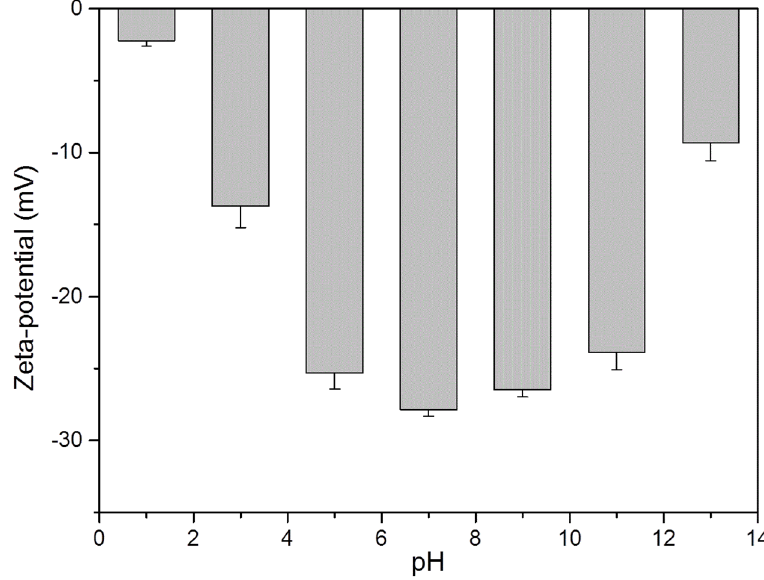
Figure 6. Zeta potential of nano chitin dispersions at different pH.